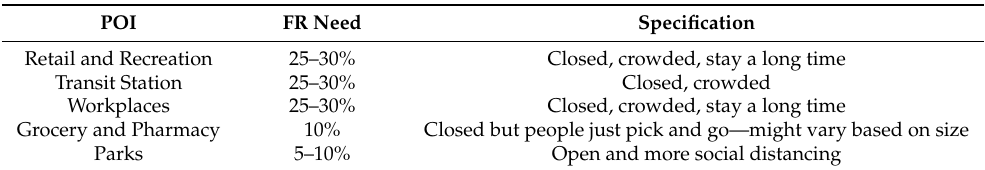
Table 4. Mobility-Restricting Measures for POIs